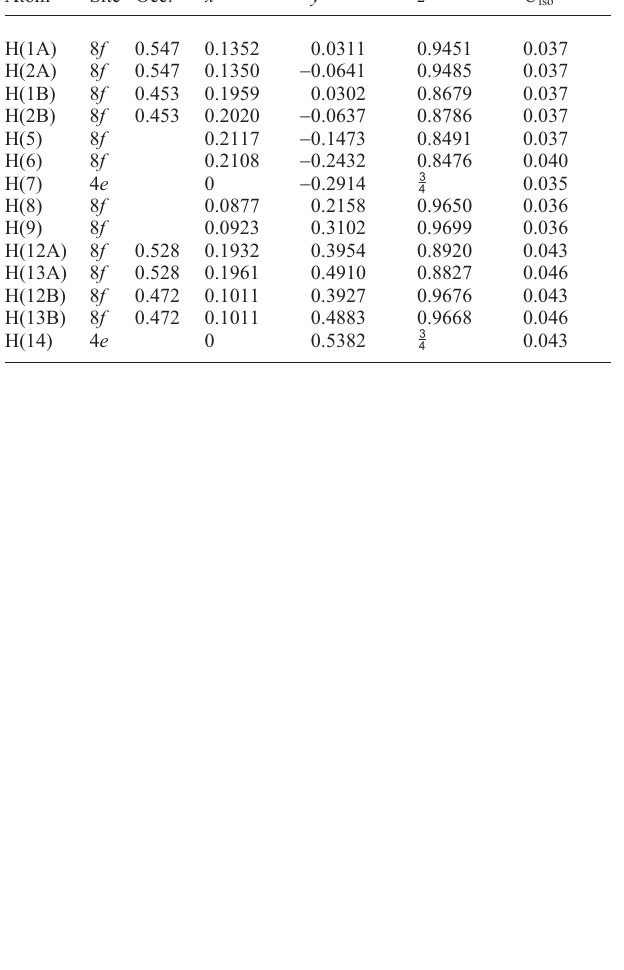
Table 2. Atomic coordinates and displacement parameters (in Å 2 ) .